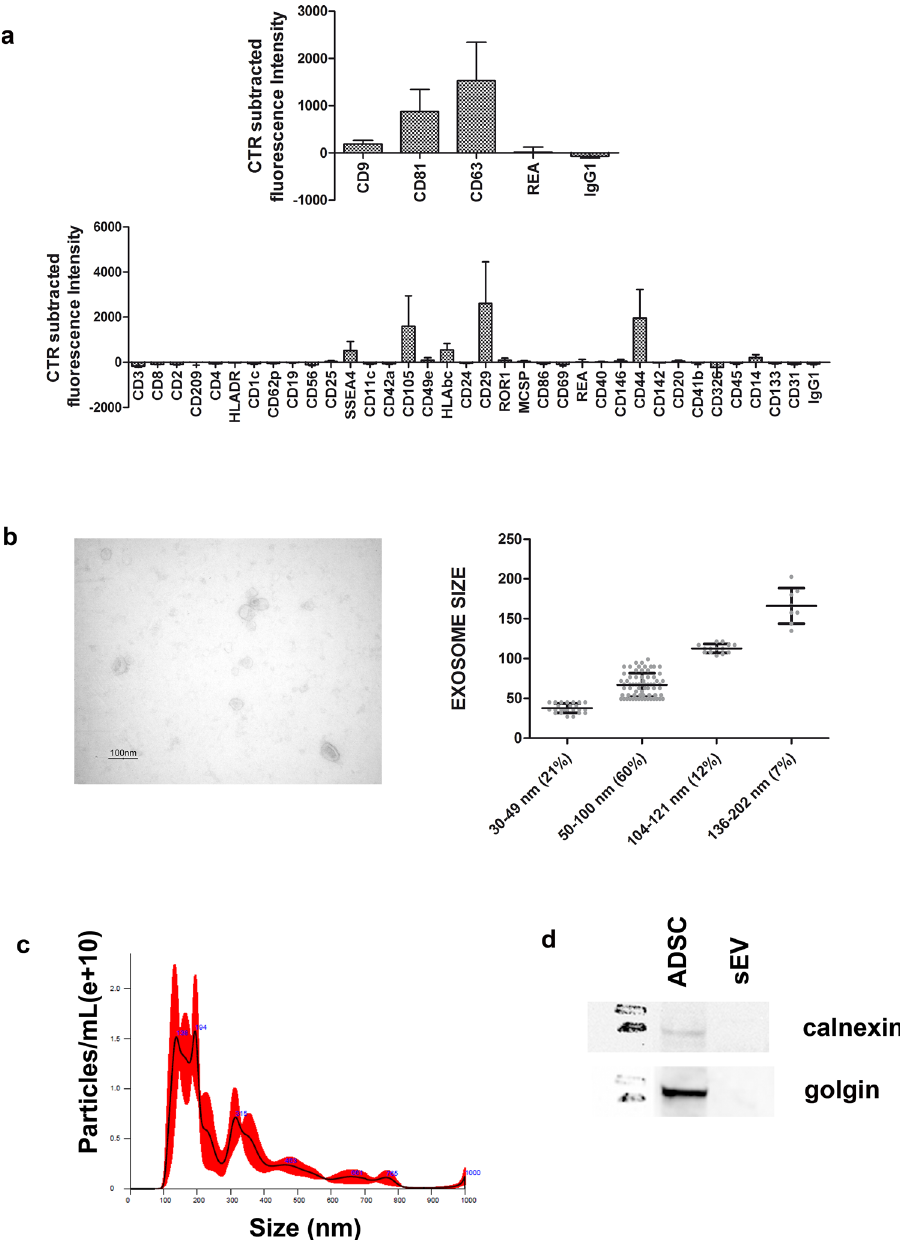
Figure 1. sEV characterization. ( a ) Surface Epitope characterization. Upper graph: control subtracted fluorescence intensity of CD9, CD63, CD81 markers and their corresponding isotype controls (IgG1, REA) of different purified sEV preparations (n = 3). Lower graph: control subtracted fluorescence intensity of the other 34 surface epitopes and isotype controls on the different purified sEV preparations (n = 3). ( b ) Transmission Electron Microscopy characterization. Left picture: transmission electron microscopy image of sEV isolated from ADSC supernatant. Scale bar, 100 nm. Right graph: data obtained from several sEV measured, grouped per size class with information about mean and standard deviation and percentage of each class. 60% of the sEV had a 50–100 nm size. ( c ) Nanotracker analysis reporting the average concentration/size. Error bars (red pattern) indicate + / − 1 standard error of the mean. ( d ) Western blot analysis indicating the absence of calnexin (marker of the endoplasmic reticulum) and of Golgin 97 (marker of Golgi apparatus) in the sEV samples (full blots available in supplementary Fig.